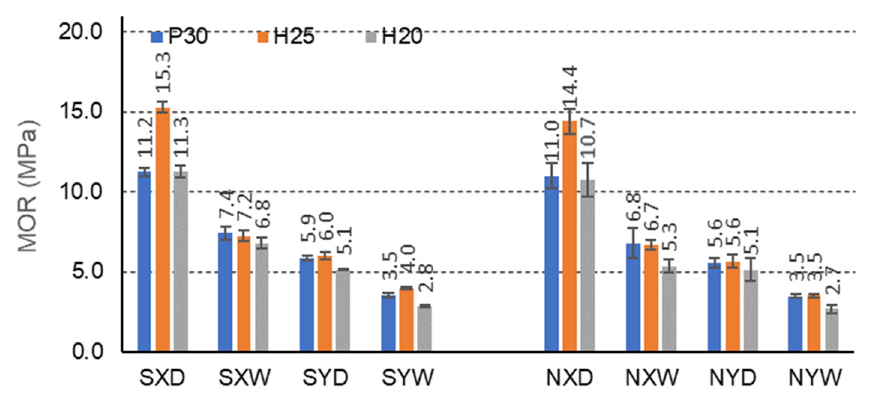
Figure 8. Illustration of the MOR relationship of honeycomb panels with F-type core. Whiskers represent standard deviations.